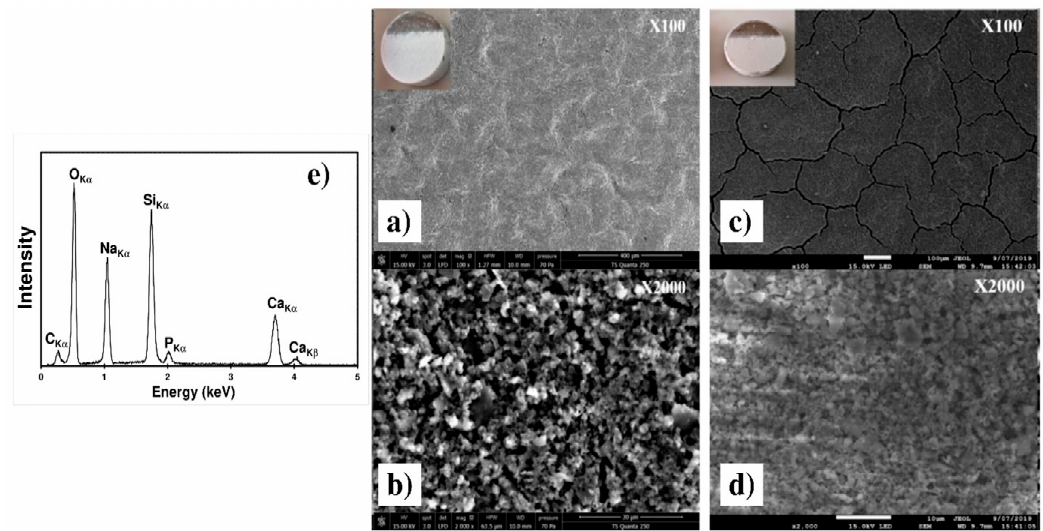
Figure 12. SEM micrographs of the C30 ( a , b ) and of the C90 ( c , d ) coatings on the Ti6Al4V alloy after heat treatment at two different magnifications. ( e ) EDXS spectrum of the heat treated C30 coating.